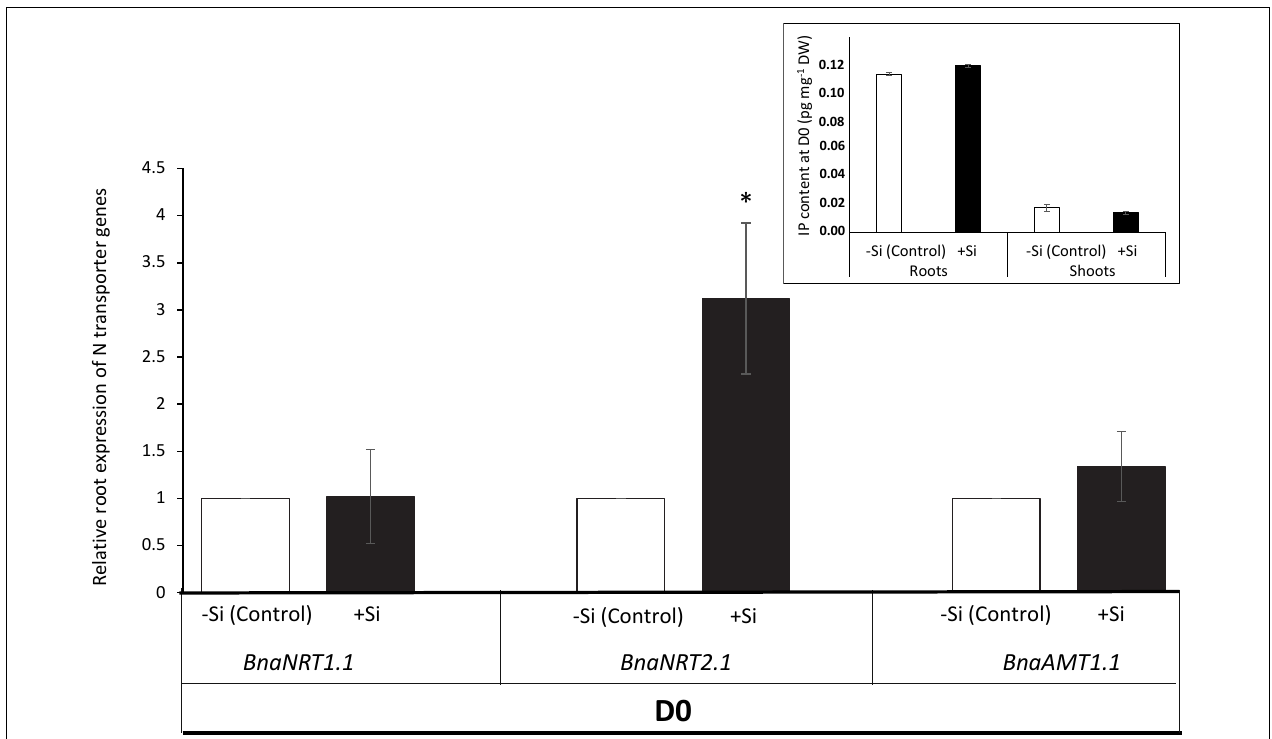
FIGURE 3 | Relative root expression of the BnaNRT1.1 , BnaNRT2.1 , and BnaAMT1.1 genes in Brassica napus L. at the end of the Si pretreatment period (D0). This harvest time (Day 0) corresponds to the end of the pretreatment period of plants with (+Si) or without Si (–Si; Control). Insert represents active cytokinin (Isopentenyladenine: IP) contents in roots. Detail of cytokinin contents are available in Supplementary Table S1 . Data are means ± SE (for n = 4). ∗ indicates significant differences between –Si (control) and +Si plants with p < 0.05.